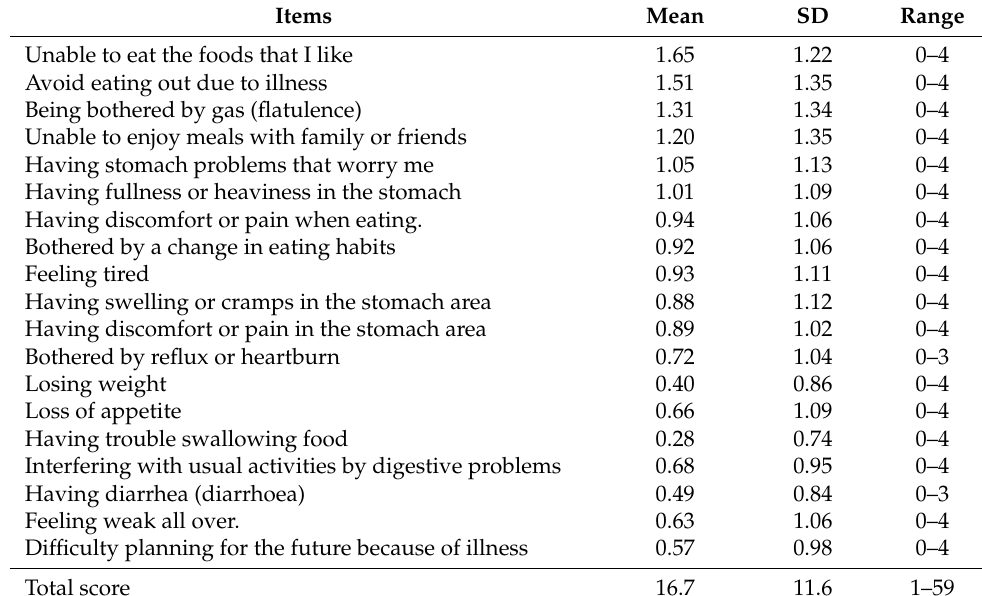
Table 2. Participants’ symptoms and adverse effects associated with gastric cancer treatment (N =